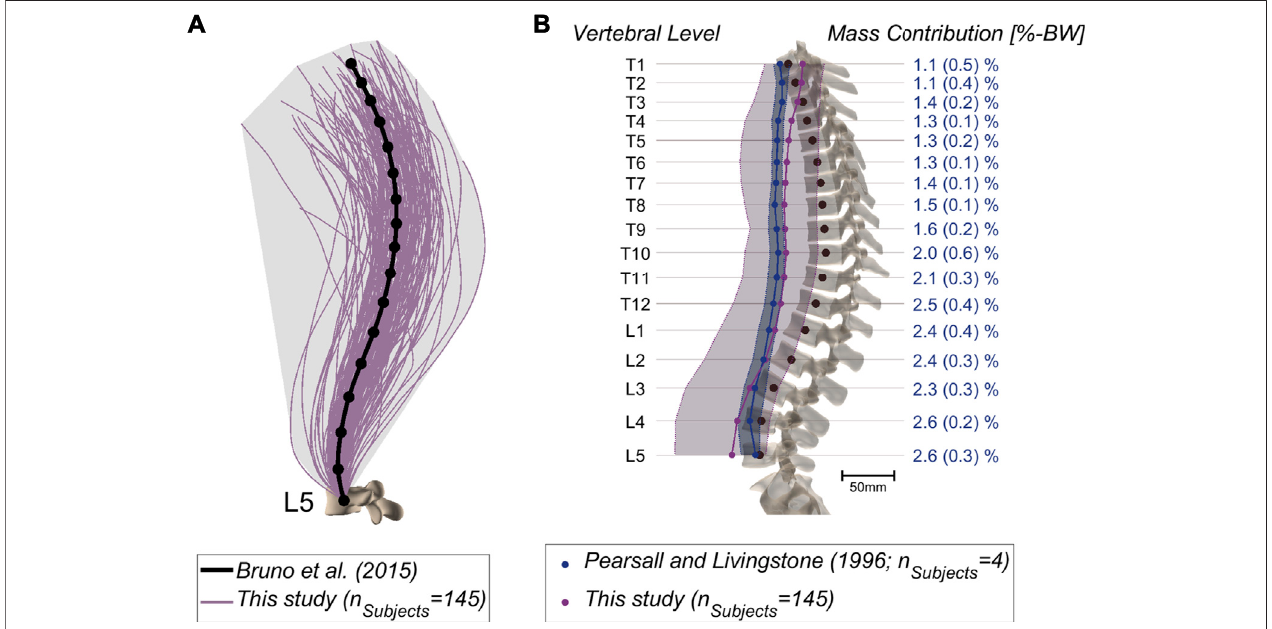
FIGURE 4 | Mean magnitude of JRFs during fl exion-extension movement of the upper body. All segments refers to the average loading across the six considered joints (T12L1 to L5S1). The error bars indicate the standard deviation.